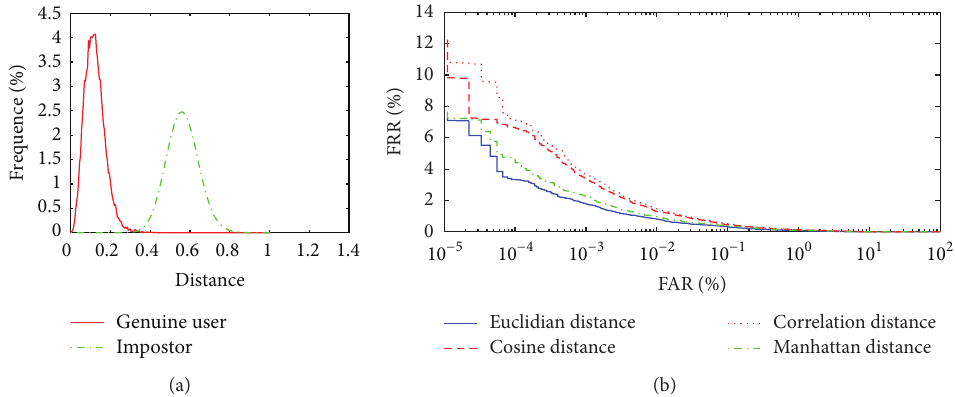
Figure 10: (a) Distribution of the genuine user and impostor based WLPP using Euclidian classifier. (b) ROC curve based WLPP to different classifiers.